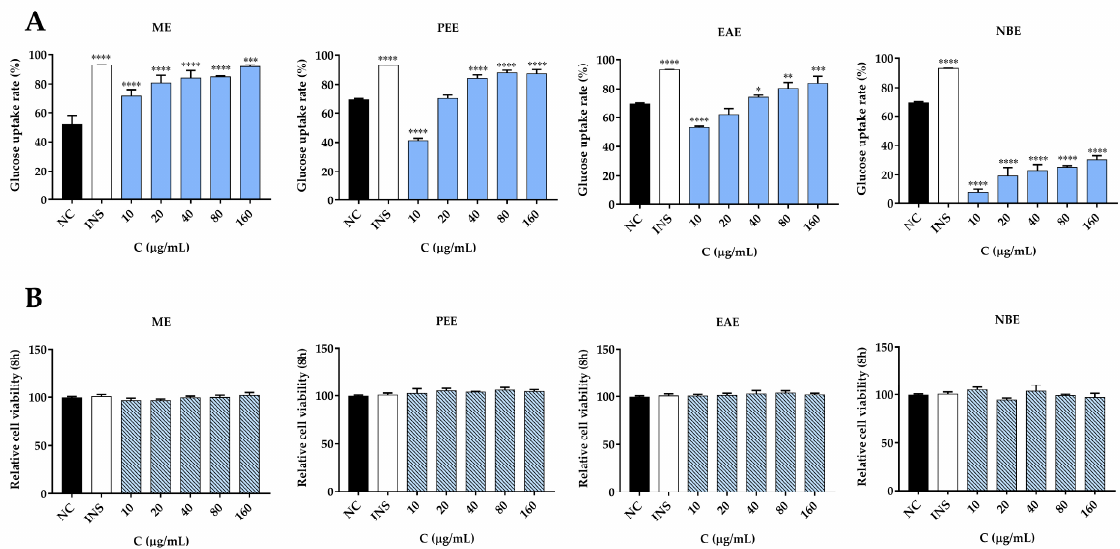
Figure 10. Glucose uptake and cell viability of 3T3-L1 adipocytes treated with T. grandis methanolic extract and fractions. ( A ) Glucose uptake rates of different groups (ME, PEE, EAE, and NBE). Insulin and berberine were used as positive controls. ( B ) Cell viability of different groups. All values are mean ± SD from three independent experiments. Significance is denoted by symbols: * p < 0.05, ** p < 0.01, and *** p < 0.001, **** p < 0.0001. ME: methanolic extract, PEE: petroleum ether extract, EAE: EtOAc extract and NBE: n-BuOH extract. NC: blank control group, INS: positive control group, 10–160: sampling